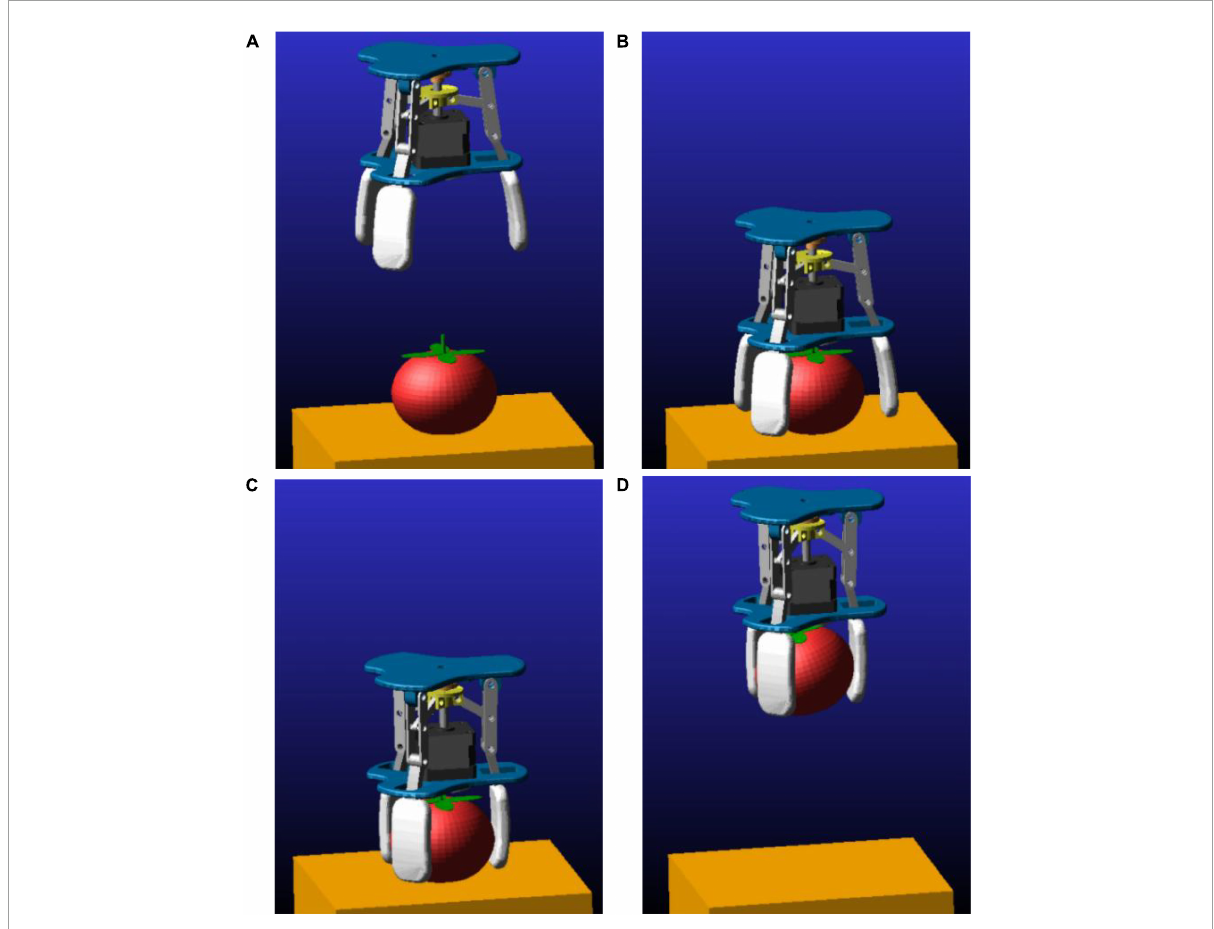
FIGURE12 Gripper gripping state simulation (A) adjustment phase; (B) descending phase; (C) grasping phase; (D) uplift